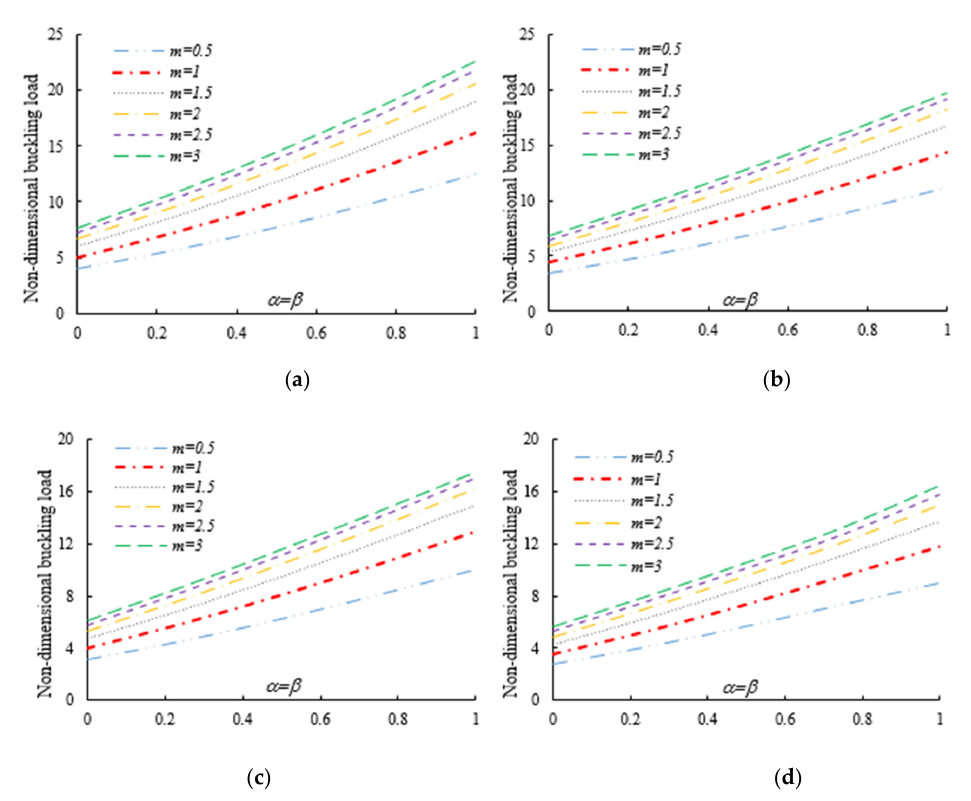
Figure 8. Variation in the flexural–torsional buckling load of I-tapered nanobeams with the tapering ratio and power-law exponent, for different nonlocality parameters (axial load on the TF at x = 0): ( a ) µ = 0; ( b ) µ = 1; ( c ) µ = 2; ( d ) µ = 3.